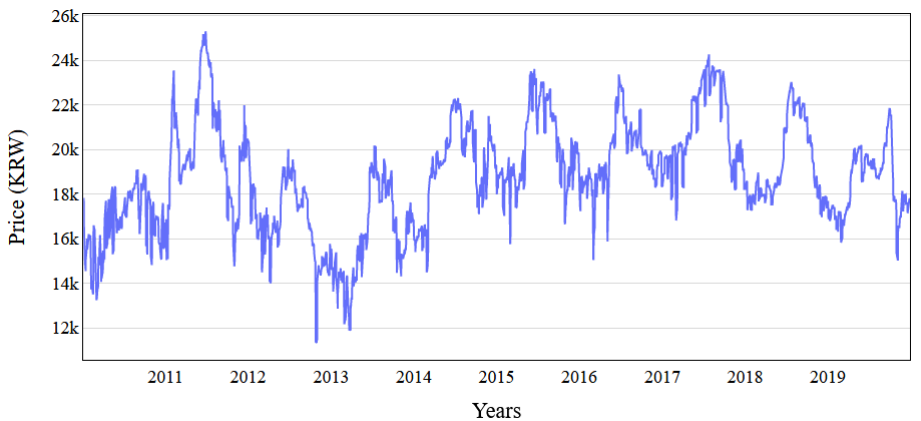
Figure 6. Daily retail pork prices (from January 2010 to December 2019).